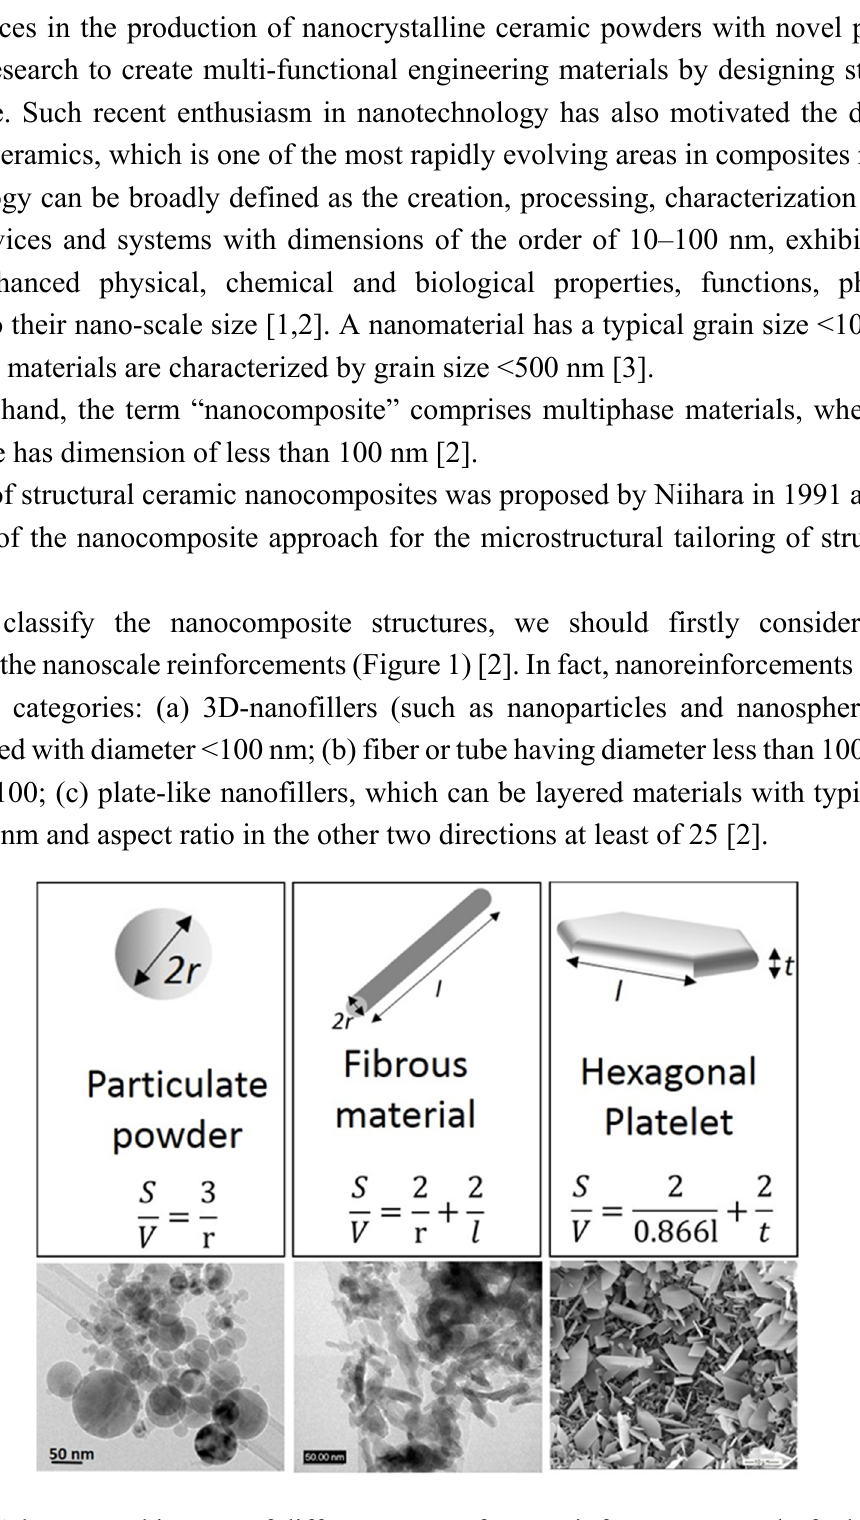
Figure 1. Schemes and images of different types of nanoreinforcements, redrafted from [2]. Surface area/volume relations for different reinforcement geometries are also